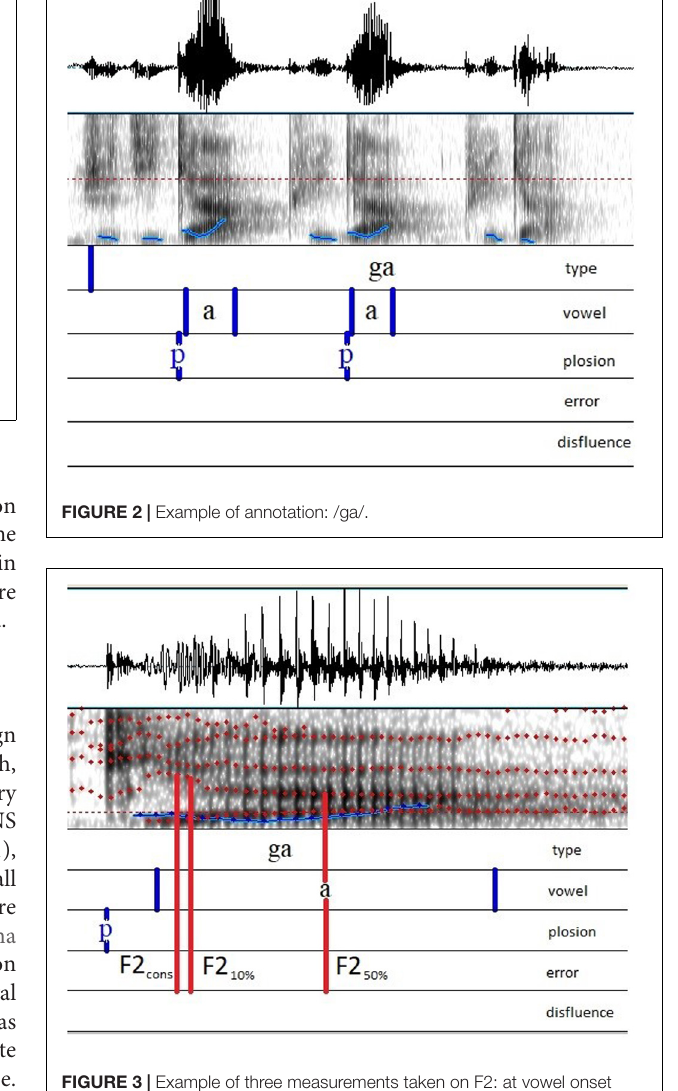
FIGURE 3 | Example of three measurements taken on F2: at vowel onset